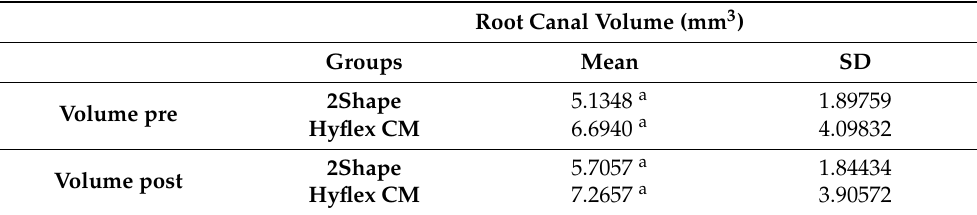
Table 4. Root canal volume pre ‐ and post ‐ brushing with 2Shape and HyFlex CM rotary instruments